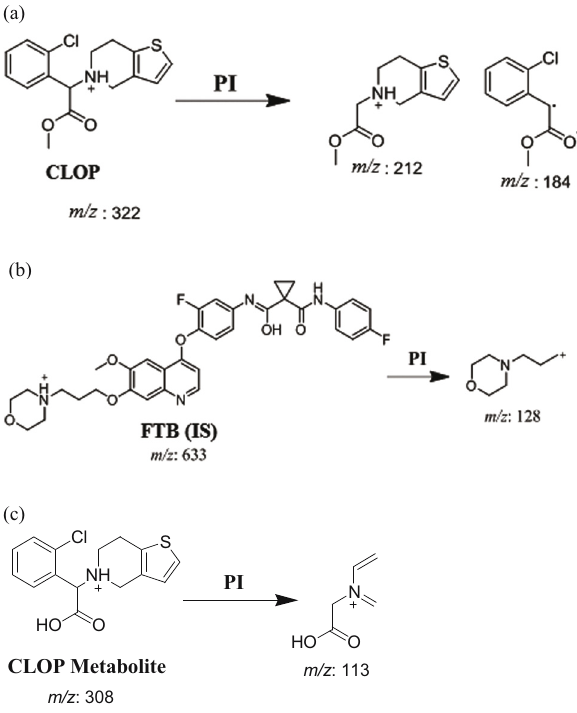
Figure 2: MRM mass spectra of ( a ) CLOP, ( b ) FTB, and ( c ) CLOP